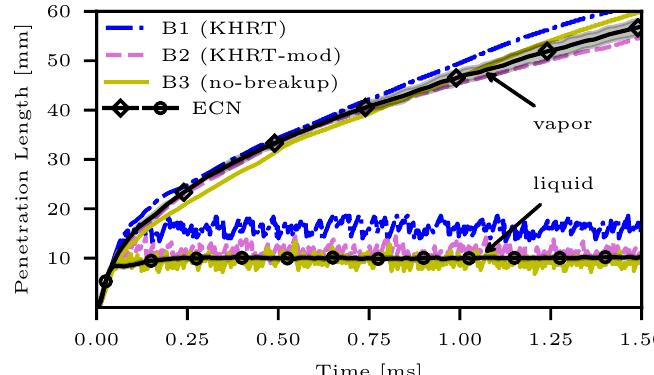
Figure 8. Time-resolved liquid and vapor penetrations of different secondary breakup models utilizing implicit LES (ILES) and D cyl = 5 d n , compared with ECN data. Filled region denotes ECN experimental uncertainty within an